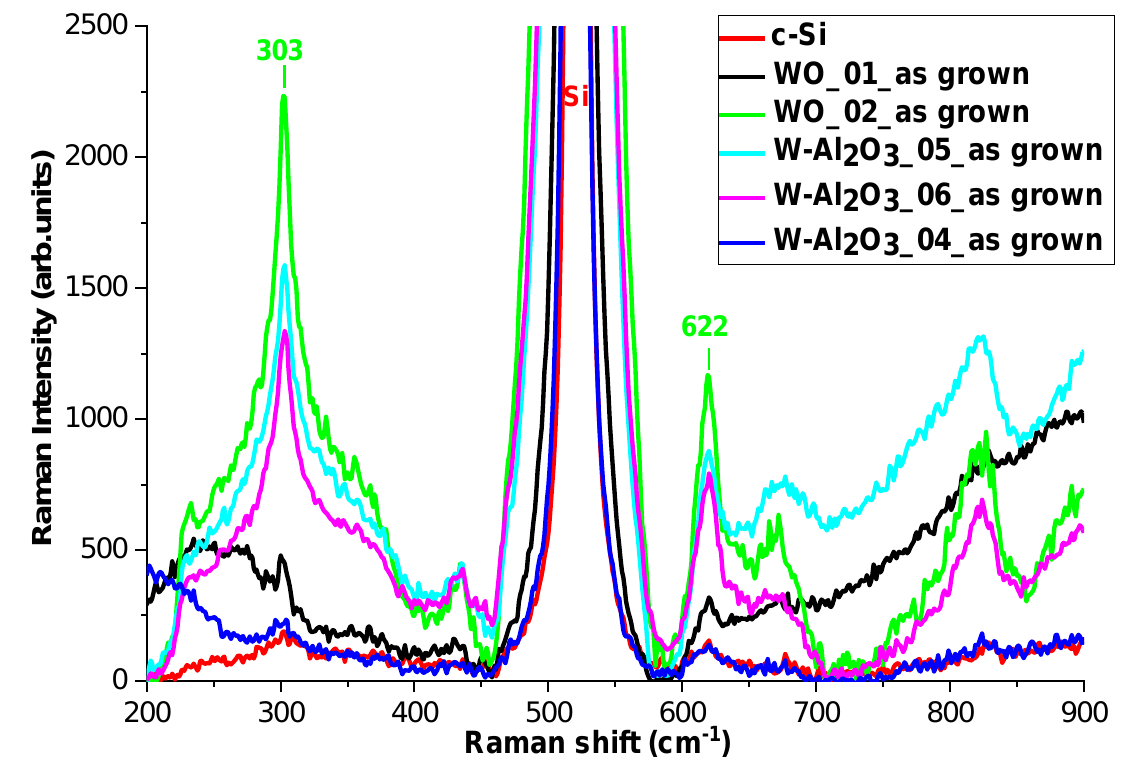
Figure 10. Comparison between Raman spectra of cermet and WO samples deposited on c-Si substrate by varying reactive gas flow.